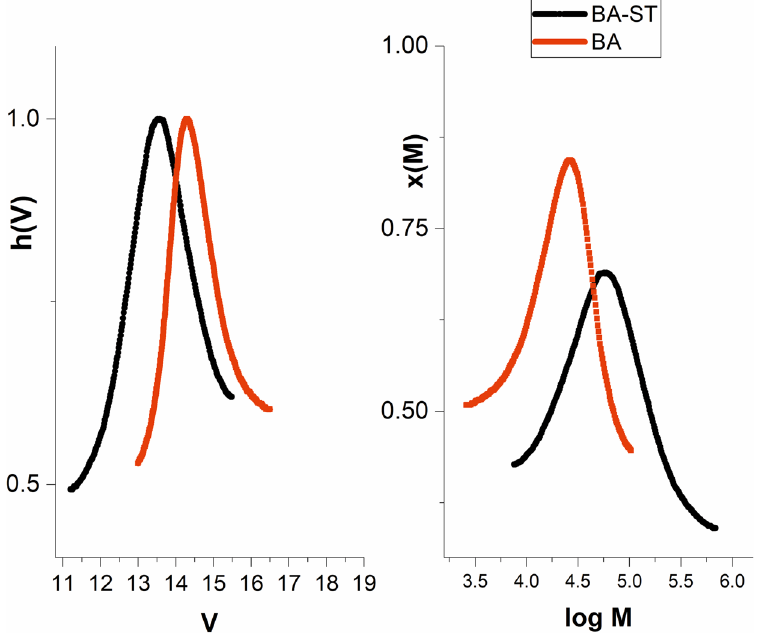
Figure 5. GPC traces for block poly(n butyl acrylate-block-styrene) synthesized using CuNPs/SiO 2 catalyst.